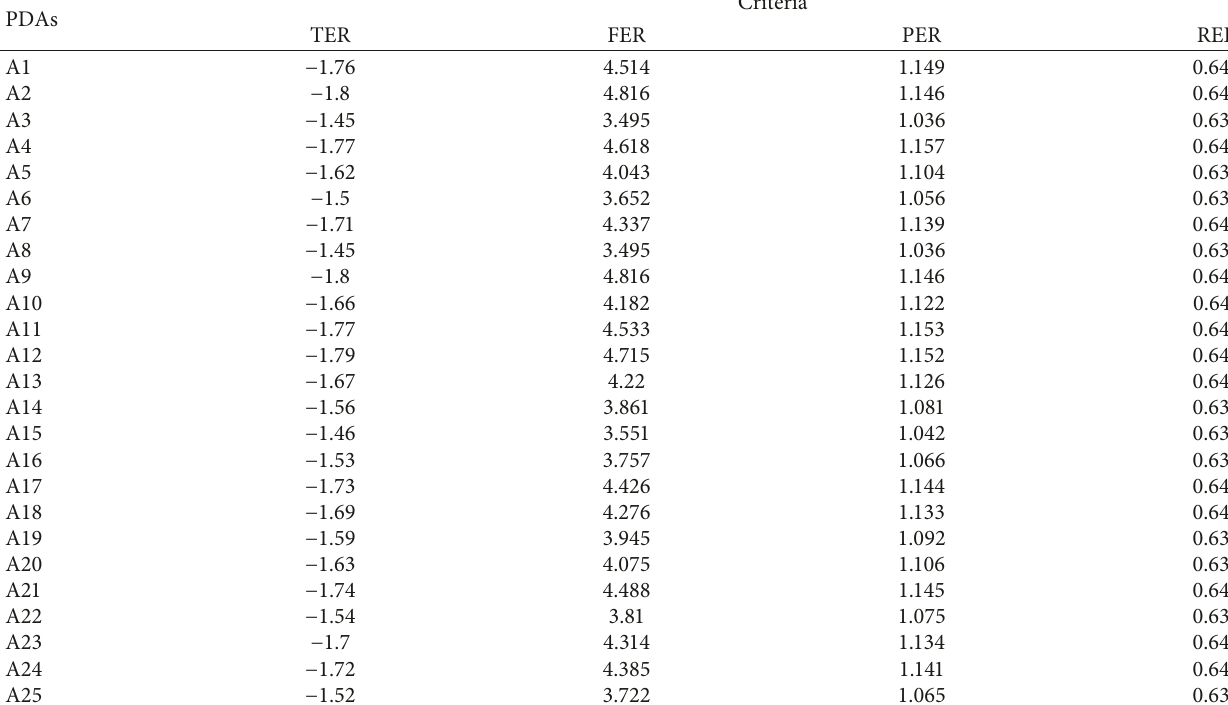
Table 11: Details of alternatives and criteria (decision matrix).